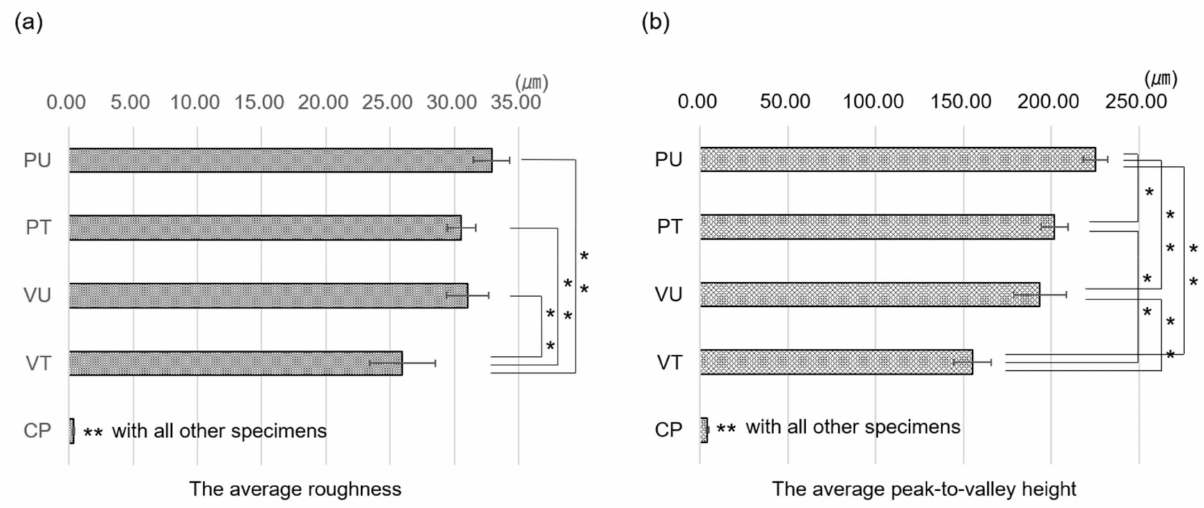
the others. * p < 0.05, ** p <